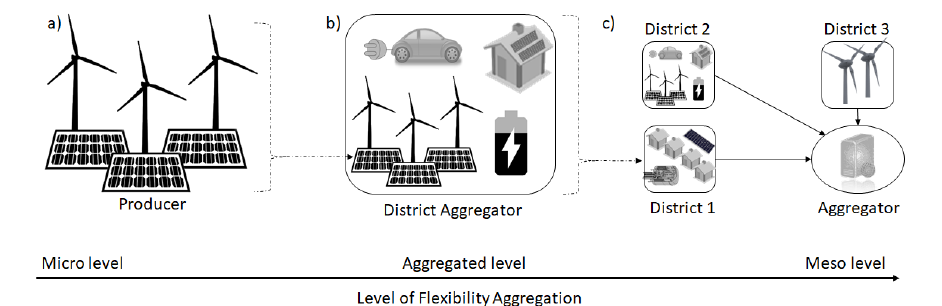
Figure 3. Business models in an local flexibility markets (LFM) and the level of aggregated flexibility ( a ) producer (micro), ( b ) district aggregator (aggregated), and ( c ) aggregator